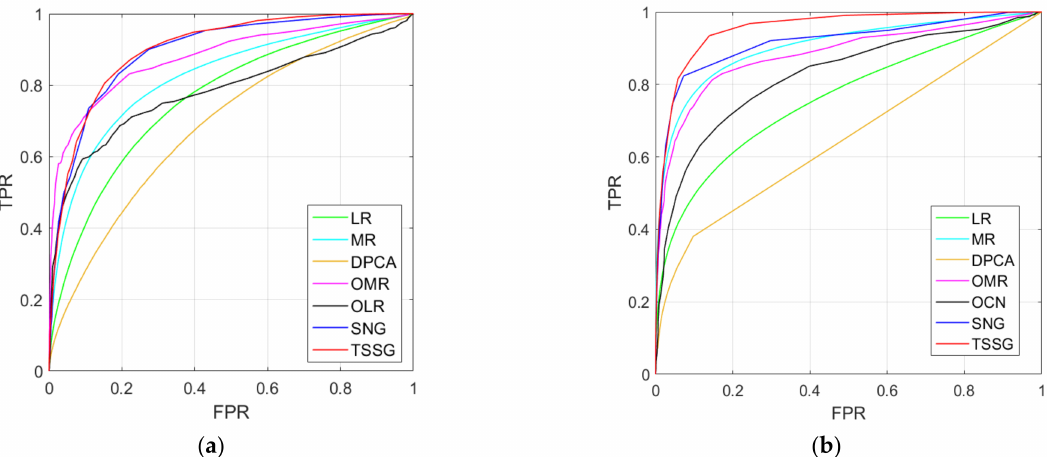
Figure 17. ROC curves of different methods on the two SAR data sets: ( a ) Beijing; ( b ) Wuhan.